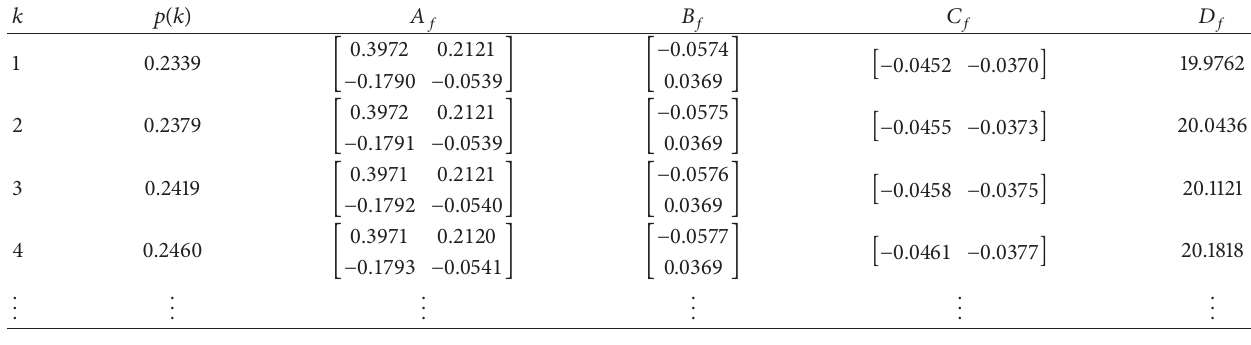
Table 1: The time-varying filter parameters.